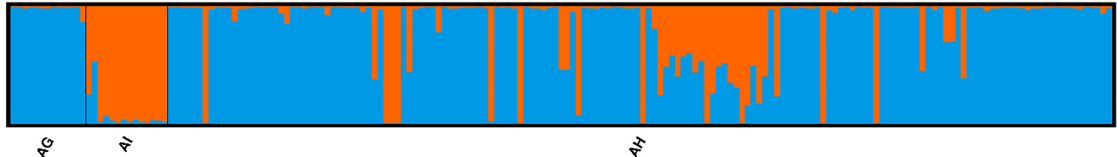
Figure 3. Genetic differentiation of the alder species groups based on the Bayesian admixture clustering with K = 2 (highest delta K value of 975.007 was for K = 2; Figure S1 and Table S3). In the plot, individuals are represented by a thin vertical bar divided into K = 2 colored segments that represent the individual’s estimated membership fractions. The black vertical lines separate the three species groups.